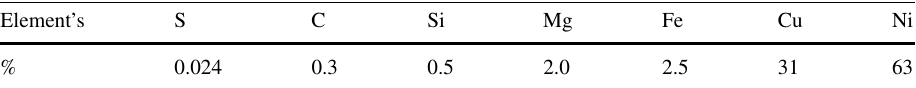
Table 2 Composition of the workpiece